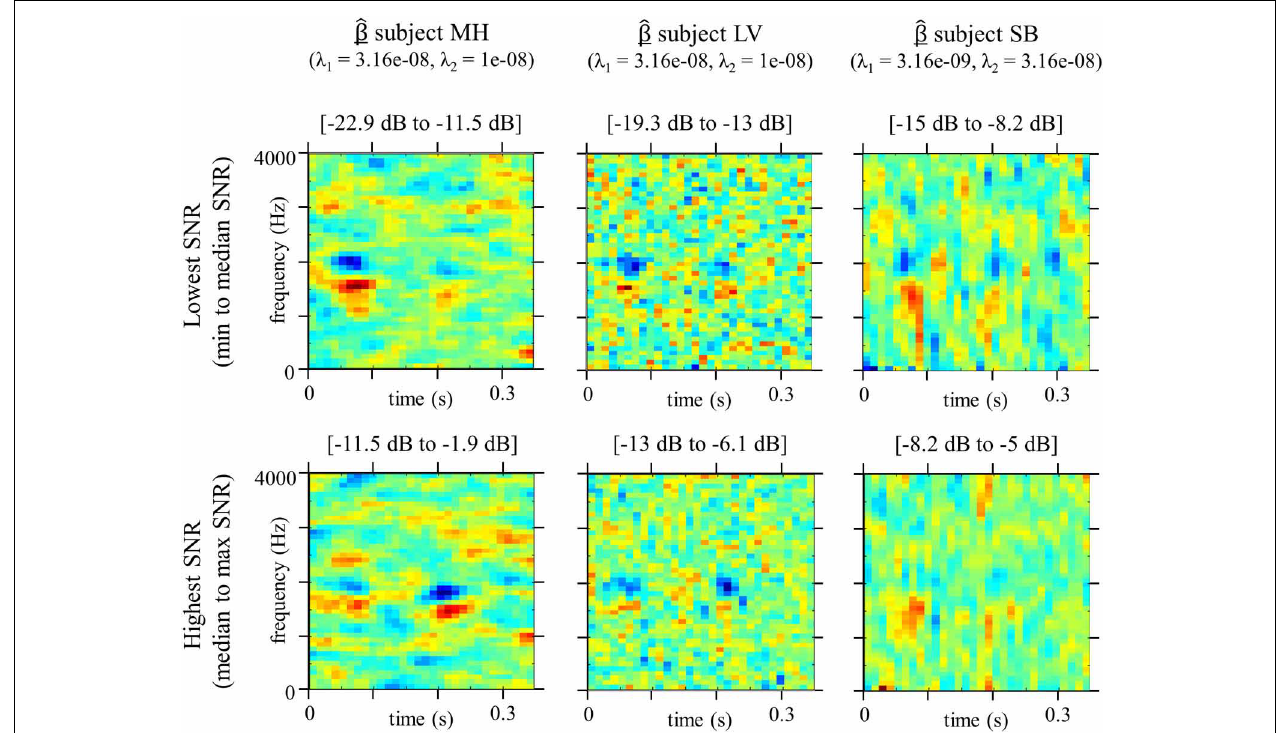
estimate). Hyperparameters values are the same as for the “overall” Classification Images Figure 4 . Weights are divided by their maximum absolute